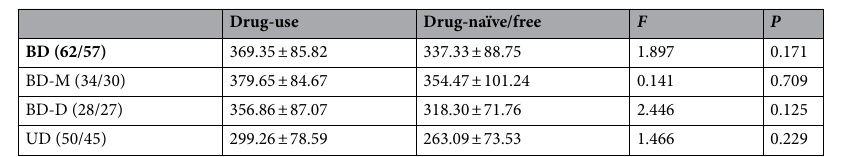
Table 4. UA levels of drug-use and drug-naïve/free subgroups (mean ± SD, μmol/L). Age, sex, history of smoking, family history, age of onset, mood episode numbers, duration of disease, whether with psychotic symptom and lipid indices as covariates. UA, uric acid; BD-M, mania/hypomania; BD-D, bipolar depression; UD, unipolar deprssion; SD, Standard deviation.